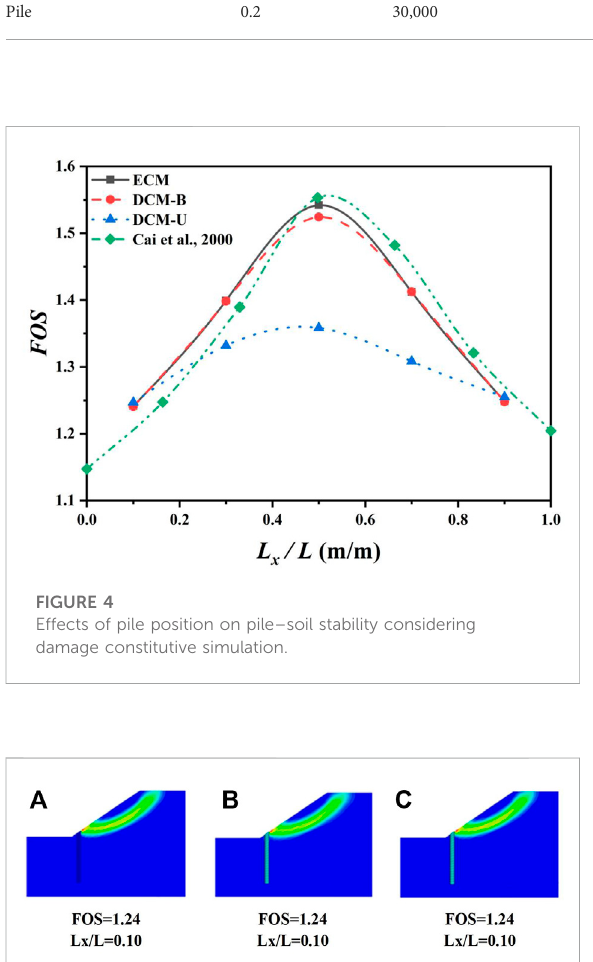
FIGURE 5 Positional variation of the slip surface at the toe of the slope for (A) the ECM, (B) DCM-U, and (C) DCM-B.